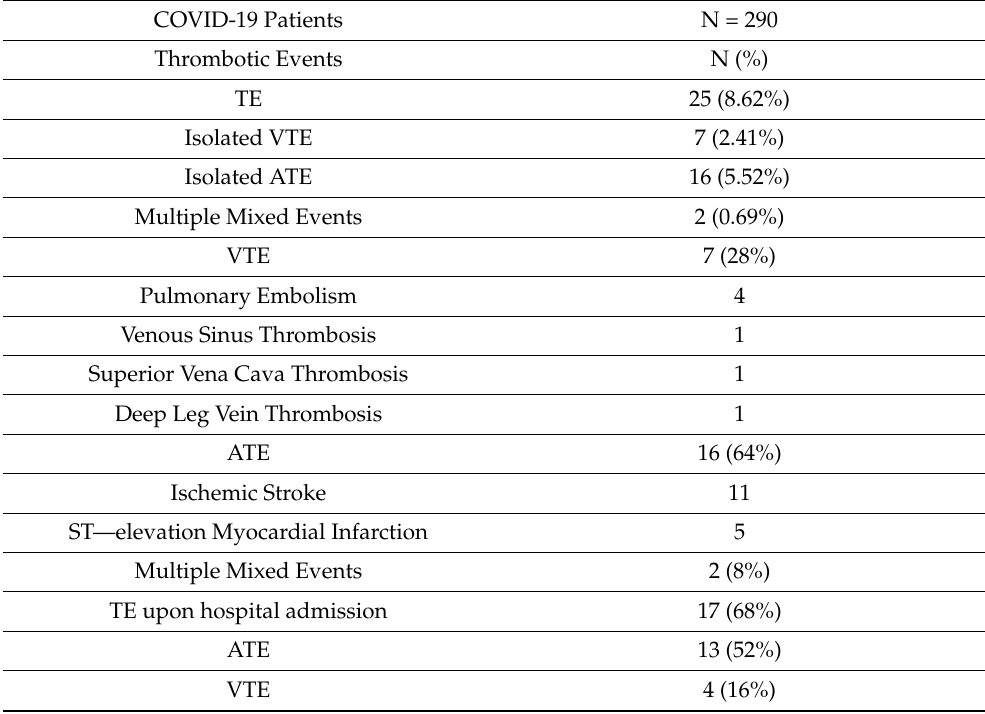
Table 2. Description of thromboembolic